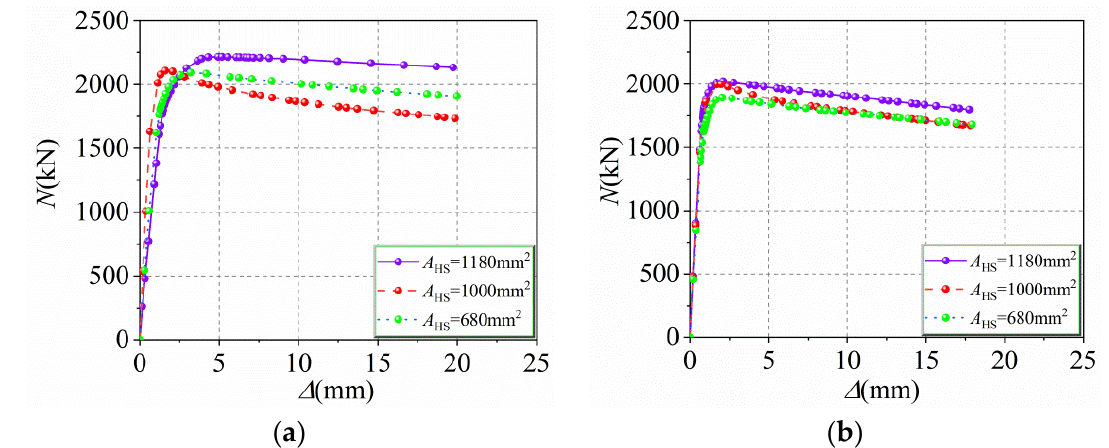
Figure 11. Curves of load–deflection for specimens with various A HS : ( a ) e = 50 mm; ( b ) e = 60 mm.